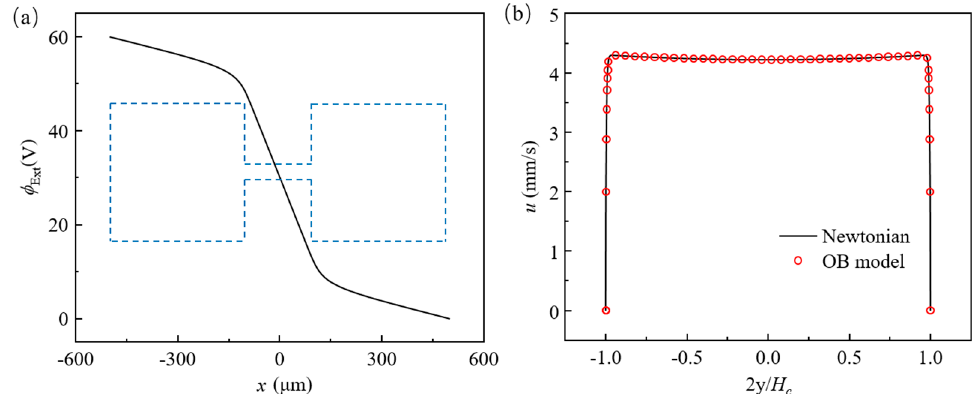
Figure 4. ( a ) Electric potential distribution (blue dash line shows the relative position of the geometry) along the x -axis; ( b ) the x -component velocity at the center of the constriction microchannel, u ( 0, y ) , for Newtonian model (solid line) and OB model (symbol).